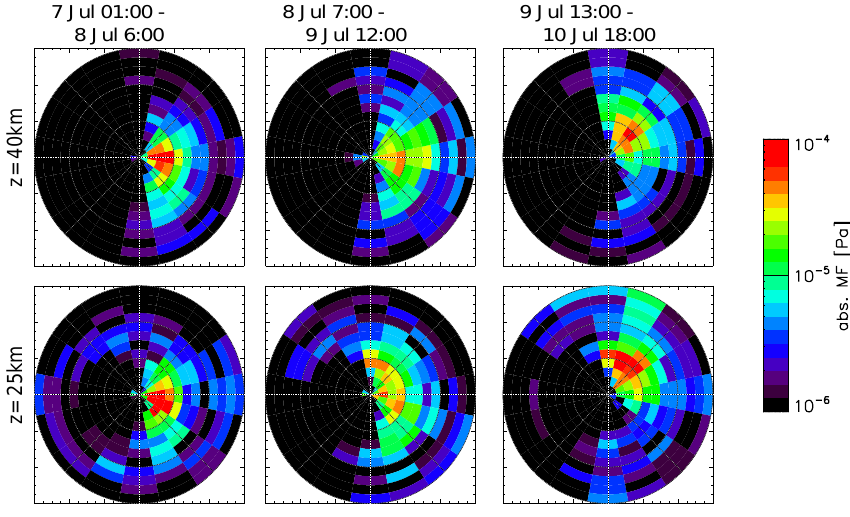
Fig. 6. As Fig. 5, but for temperatures.